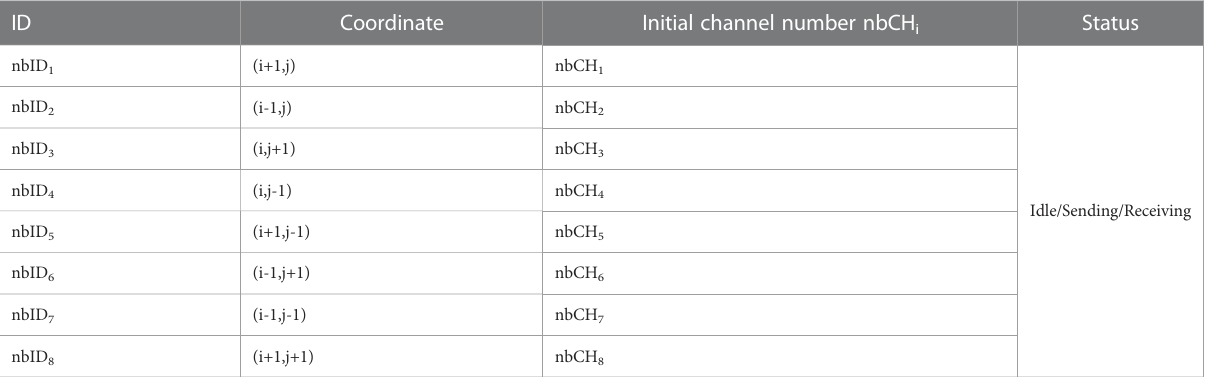
TABLE 1 Neighboring node